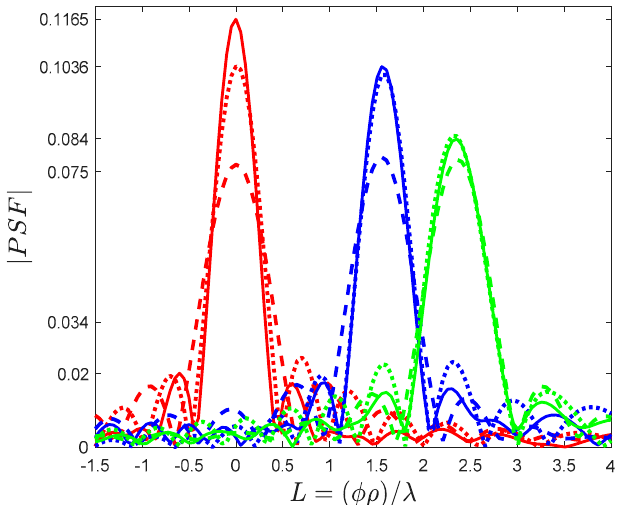
Figure 4. Comparison of the actual PSFs of three sensing modes for φ 0 = 0 (red lines), φ 0 = π /6 (blue lines), and φ 0 = π /4 (green lines). The solid, dotted, and dashed lines indicate the reflection, transmission, and angle modes.